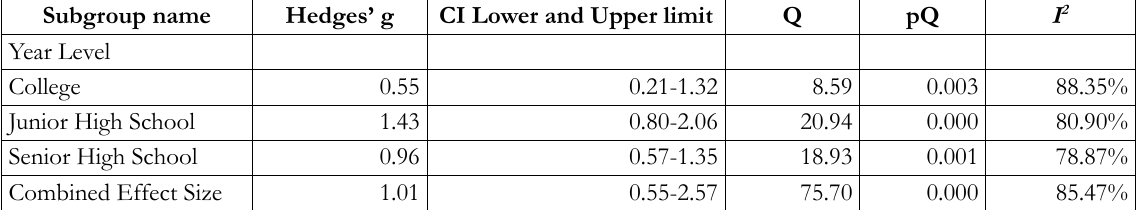
Table 9. Effect Size according to Year